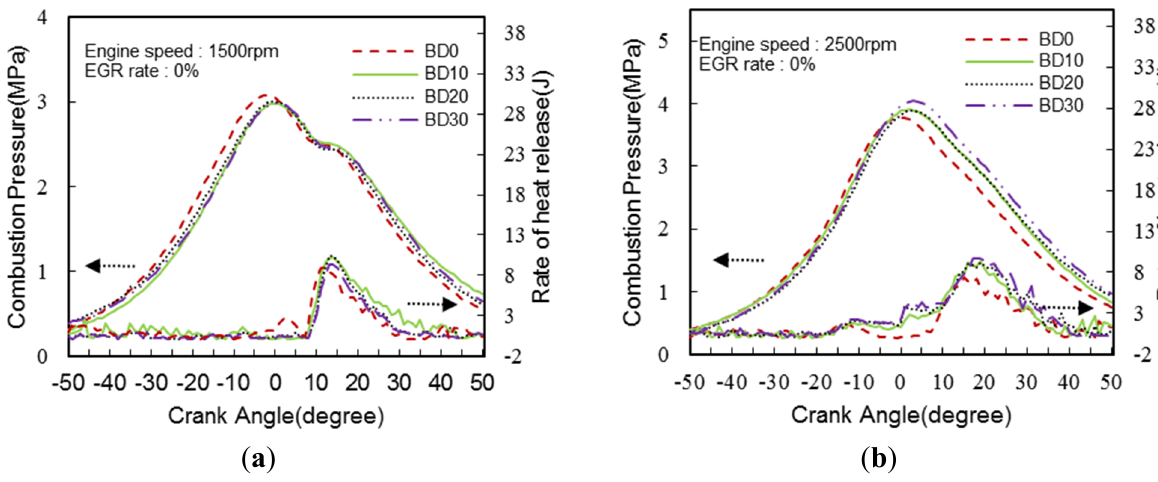
Figure 2. Effects of the biodiesel blend ratio on the combustion characteristics at ( a ) 1500 and ( b ) 2500 rpm.